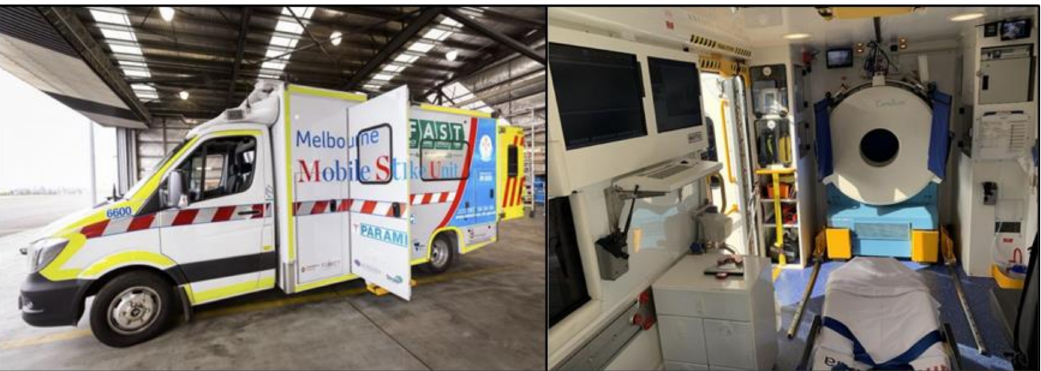
Figure 1. Exterior of Melbourne MSU (left); interior of Melbourne MSU (right) [11,14]. The image